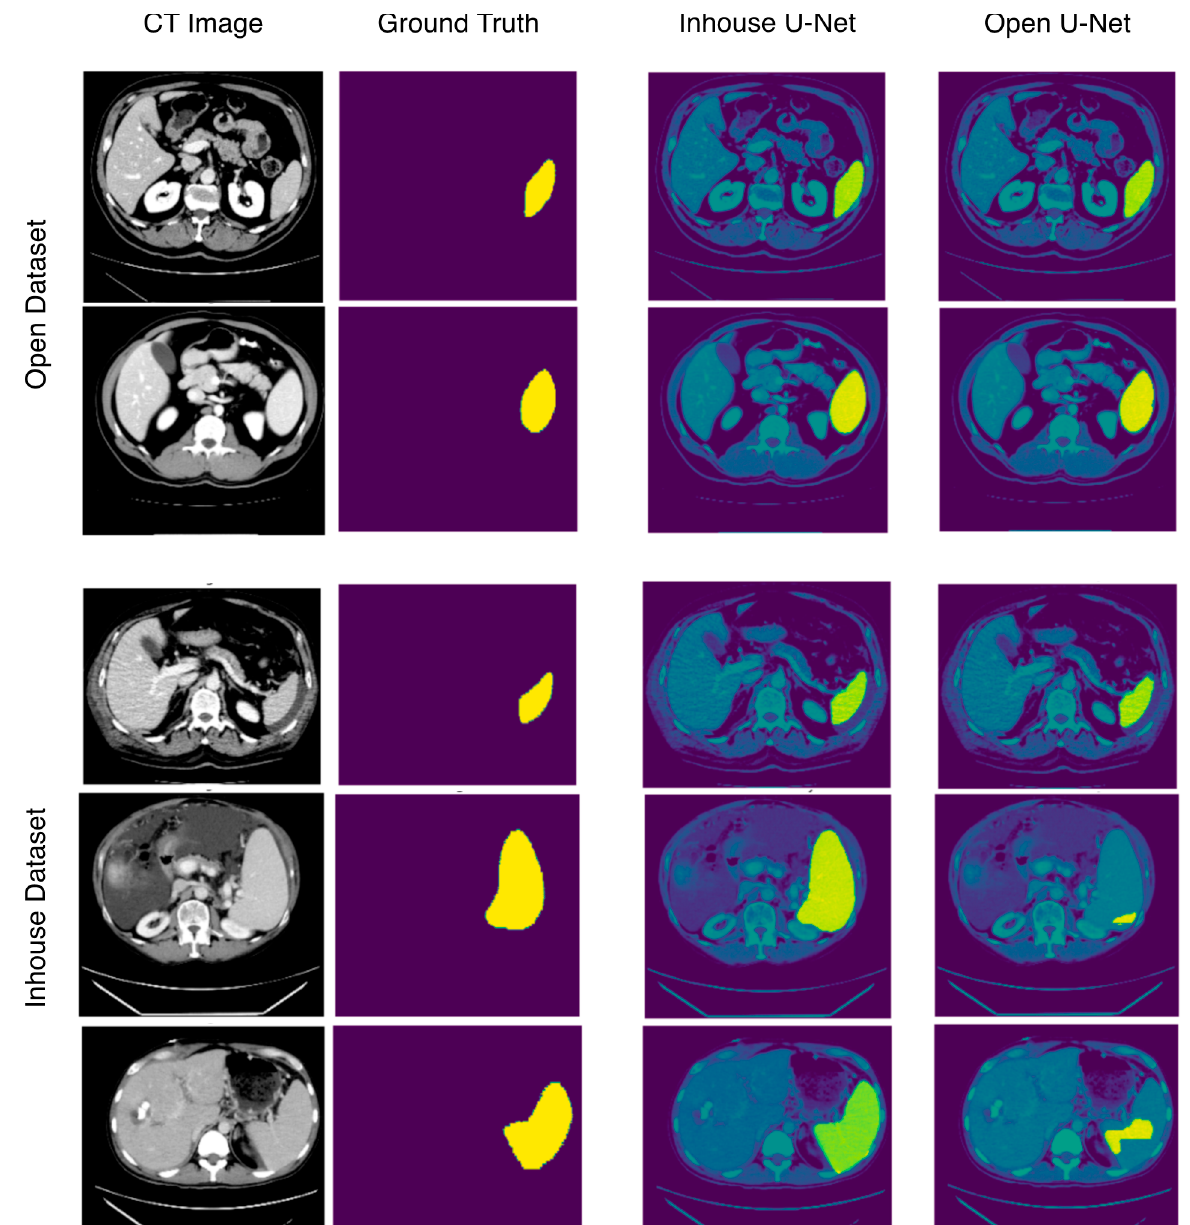
Figure 3. Sample images showing segmentation results of in-house and open U-Net using the in-house and open datasets. In the open dataset, in-house U-Net and open U-Net show performances, whereas in the in-house dataset, open U-Net shows bad segmentation results, especially in patients with splenomegaly.